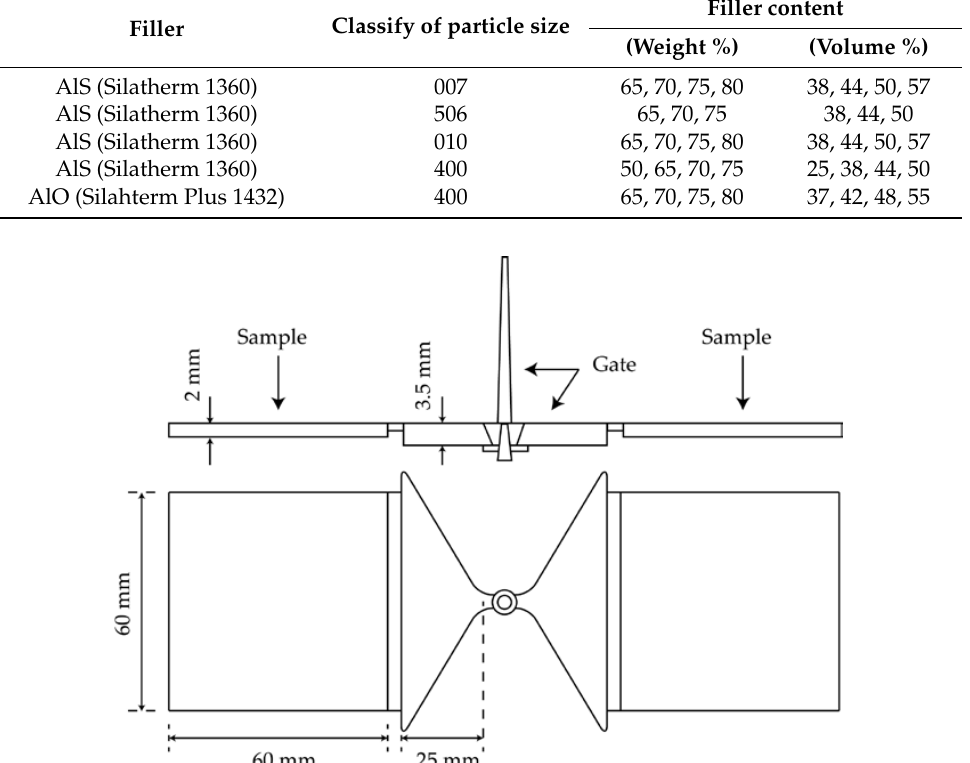
Figure 1. Used screw configuration and setting temperature of heating blocks for the preparation of composites (1. conveying elements; 2. kneading elements). Table 3. List of used fillers and their content in composites.